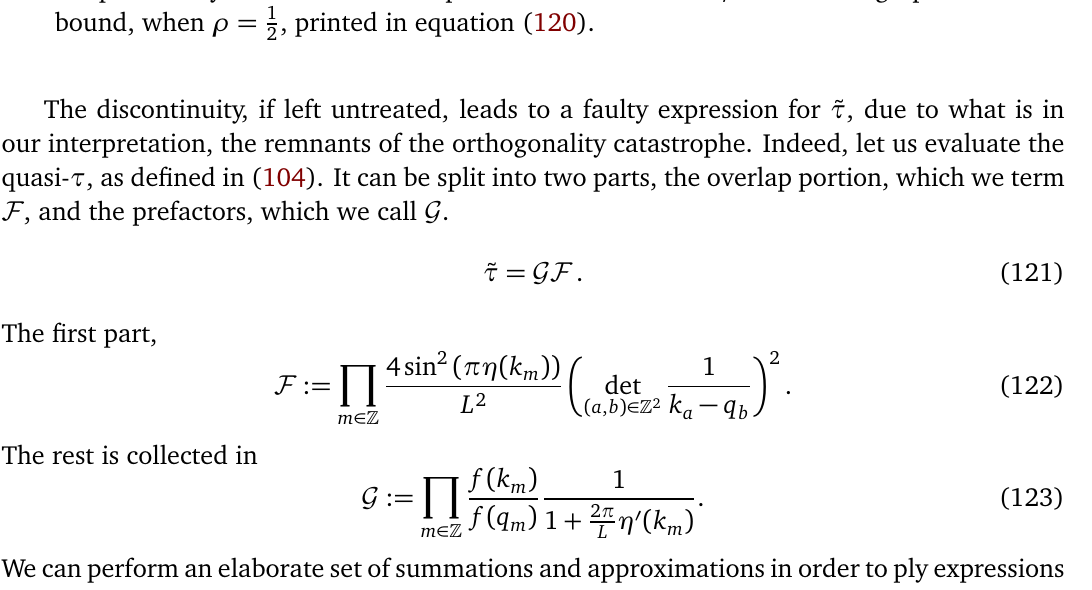
Figure 10: Scaling of the magnitude of the discontinuity ∆ as it depends on the shift ν . Two graphs are produced by equation (118) for non-extremal ρ , the value of the probability distribution at the point of inversion k = x / t . The final graph is the bound, when ρ = 1 , printed in equation 2